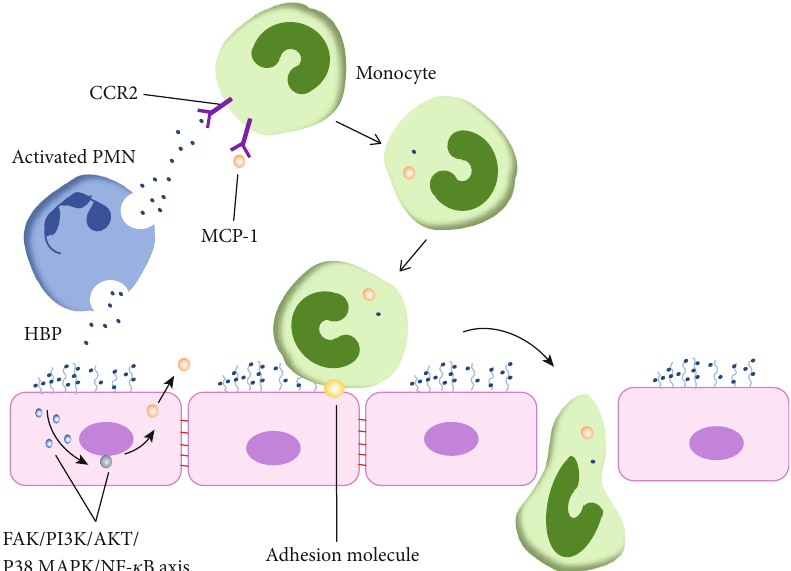
Figure 3: HBP is a potent chemoattractant factor for monocytes. This protein can interact with CCR2 to active monocytes directly, or it can trigger the FAK-PI3K-AKT-P38 MAPK-NF- κ B axis in ECs to facilitate the secretion of MCP-1, the ligand of CCR2, to induce monocytes to migrate. Additionally, HBP upregulates ICAM, VCAM, and E-selectin in the ECs, ultimately contributing to the adhesion between ECs and